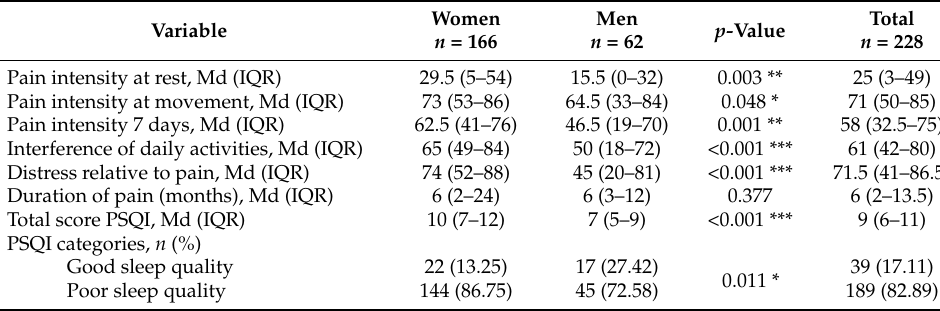
Table 2. Clinical characteristics by sex.